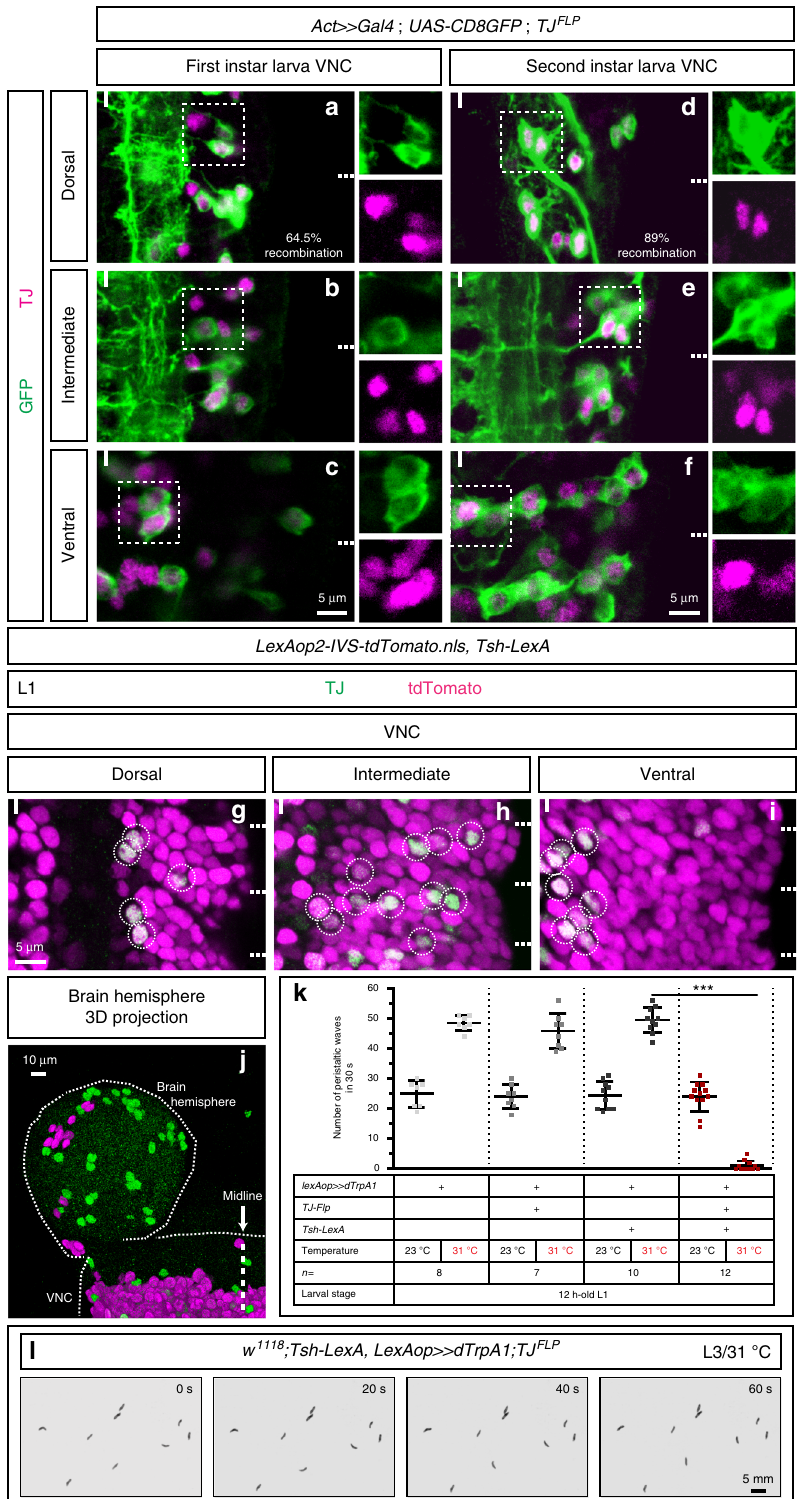
Fig. 2 TJ-Flp accurately targets TJ + neuronal subpopulations. a – f Staining for TJ (magenta) and recombined cells (expressing TJ-Flp – green) in 0 – 6 h old fi rst instar ( a – c ) and young second instar ( d – f ) larva VNC. Percentages of cells recombined are indicated. g – j Staining for TJ (green) and Tsh-LexA driving an nls-tdTomato (magenta) in fi rst instar larva VNC ( g – i ) and in fi rst instar larva brain hemisphere ( j ). All TJ + cells in the VNC are Tsh-LexA + while no co- localization is found in the brain. j A single brain hemisphere and the anterior part of the VNC are visible (left side). k Number of peristaltic waves per 30 s at (23 °C) and (31 °C) temperatures. Each single point represents a single 12-h-old fi rst instar larva. Error bars indicate the mean ± SD and n denotes the number of larvae tested. Statistical analysis: Kruskall – Wallis test *** p < 0.001. l Snapshots extracted from a 60 s time-lapse recording of nine L3 larvae upon activation of all TJ + neurons located in the VNC using the MWT (Multi-Worm Tracker) automated behavioral device